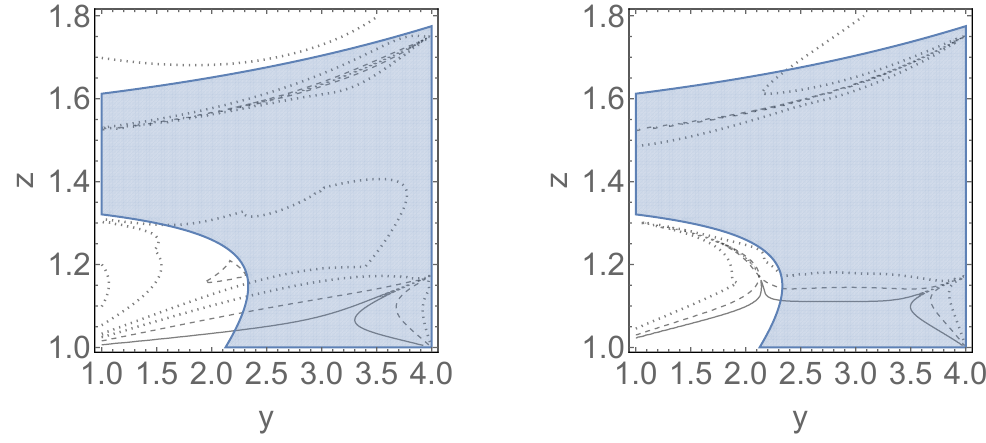
Figure 4 . In the left and right panels, we plot two ratios r 1 and r 2 of eigenvalues of the physical Yukawa couplings ( Y ) to the maximum one with respect to y and z , respectively. The dotted, ˆ3ˆ a ˆ b dashed, and solid curves correspond to the values for 0 . 5 (10 − 1 ) , 10 − 1 (10 − 2 ) , and 10 − 2 (10 − 3 ) , in the left (right) panel, respectively. In both panels, the blue shaded regions represent the allowed volume 1 < V ≤ 30